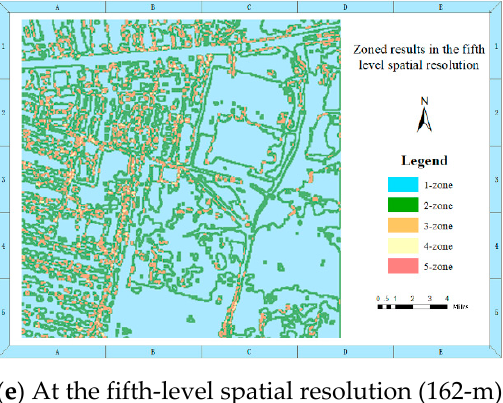
Figure 5. Zone results of remote sensing classification at five different spatial scales. Table 1. Sampling rate of each zone at the fifth-level spatial resolution (162-m).